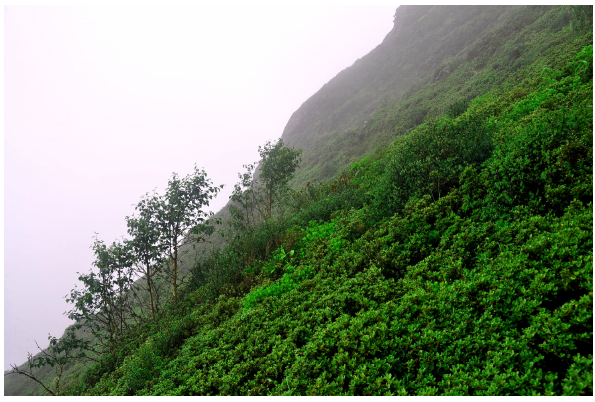
Figure 11. Tall saplings of Betula utilis (ca. 2m) growing 100– 150m above the current treeline in Langtang, Nepal (Schickhoff, 21 July